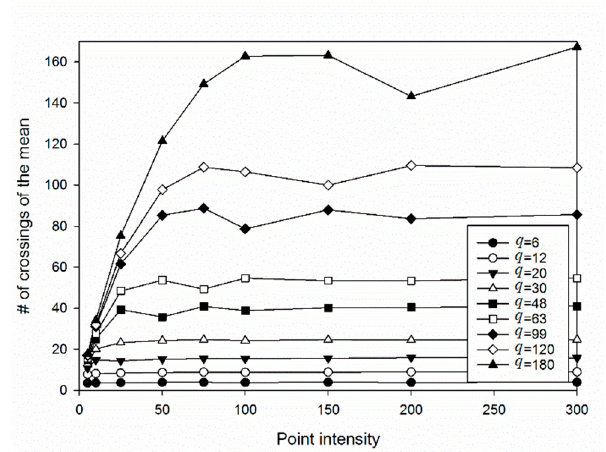
Figure 7. An example of a row in a grid under CSR and non-uniform conditions.